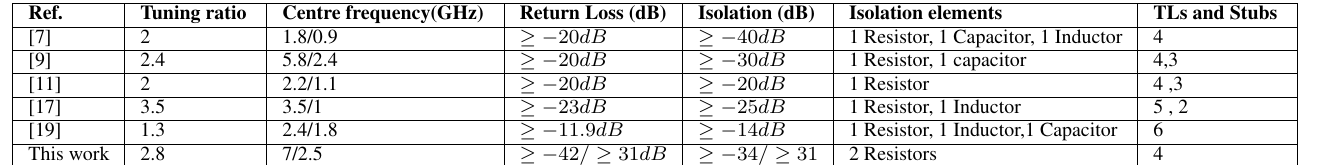
TABLE 2. Table of performance comparison of the proposed DBPD with related state-of-the-art power dividers.